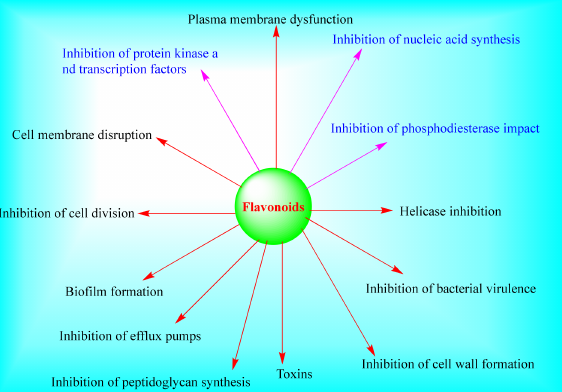
Figure 4. Summary of antibacterial and antifungal mechanisms of actions of